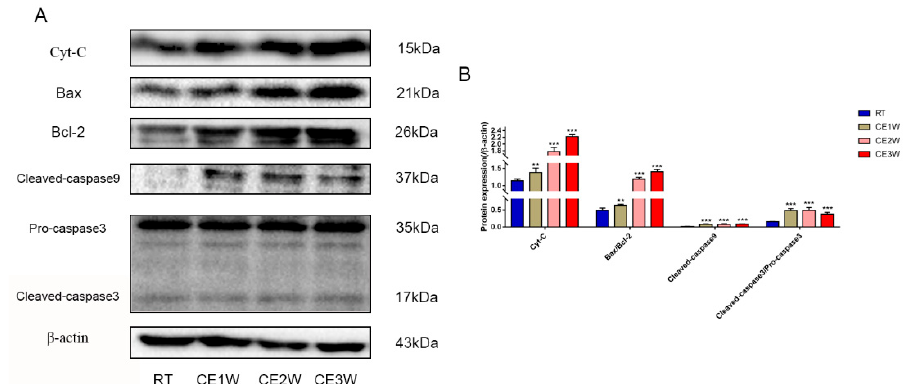
Figure 5. The expressions of kinases and key proteins on mitochondrial apoptosis signaling pathway. ( A ) Cyt-c, Bax, Bcl-2, cleaved-caspase-9, caspase-3, and β -actin (control) expressions in the hippocampal as assessed by Western blotting; the relevant expressions were analyzed and shown as graphs ( B ) in each group. Data were between RTM vs. CE1W, CE2W, and CE3W groups and were analyzed by one-way analysis of variance. The results are expressed as the mean ± SD ( n = 6) of four independent groups. ** p < 0.01; *** p < 0.001.